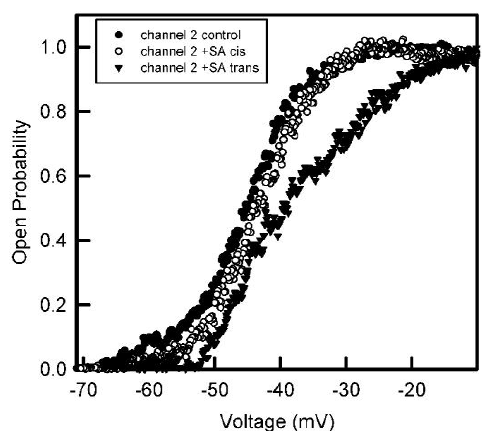
Figure 7. The voltage dependence of the probability of subunit 2 to be in the open state before and after treatment with succinic anhydride added first to the cis and then to the trans side of the membrane. Addition to the cis side resulted in no significant change in n (from 5.3 to 6.1) but addition to the trans compartment caused the n value to drop to 2.8.